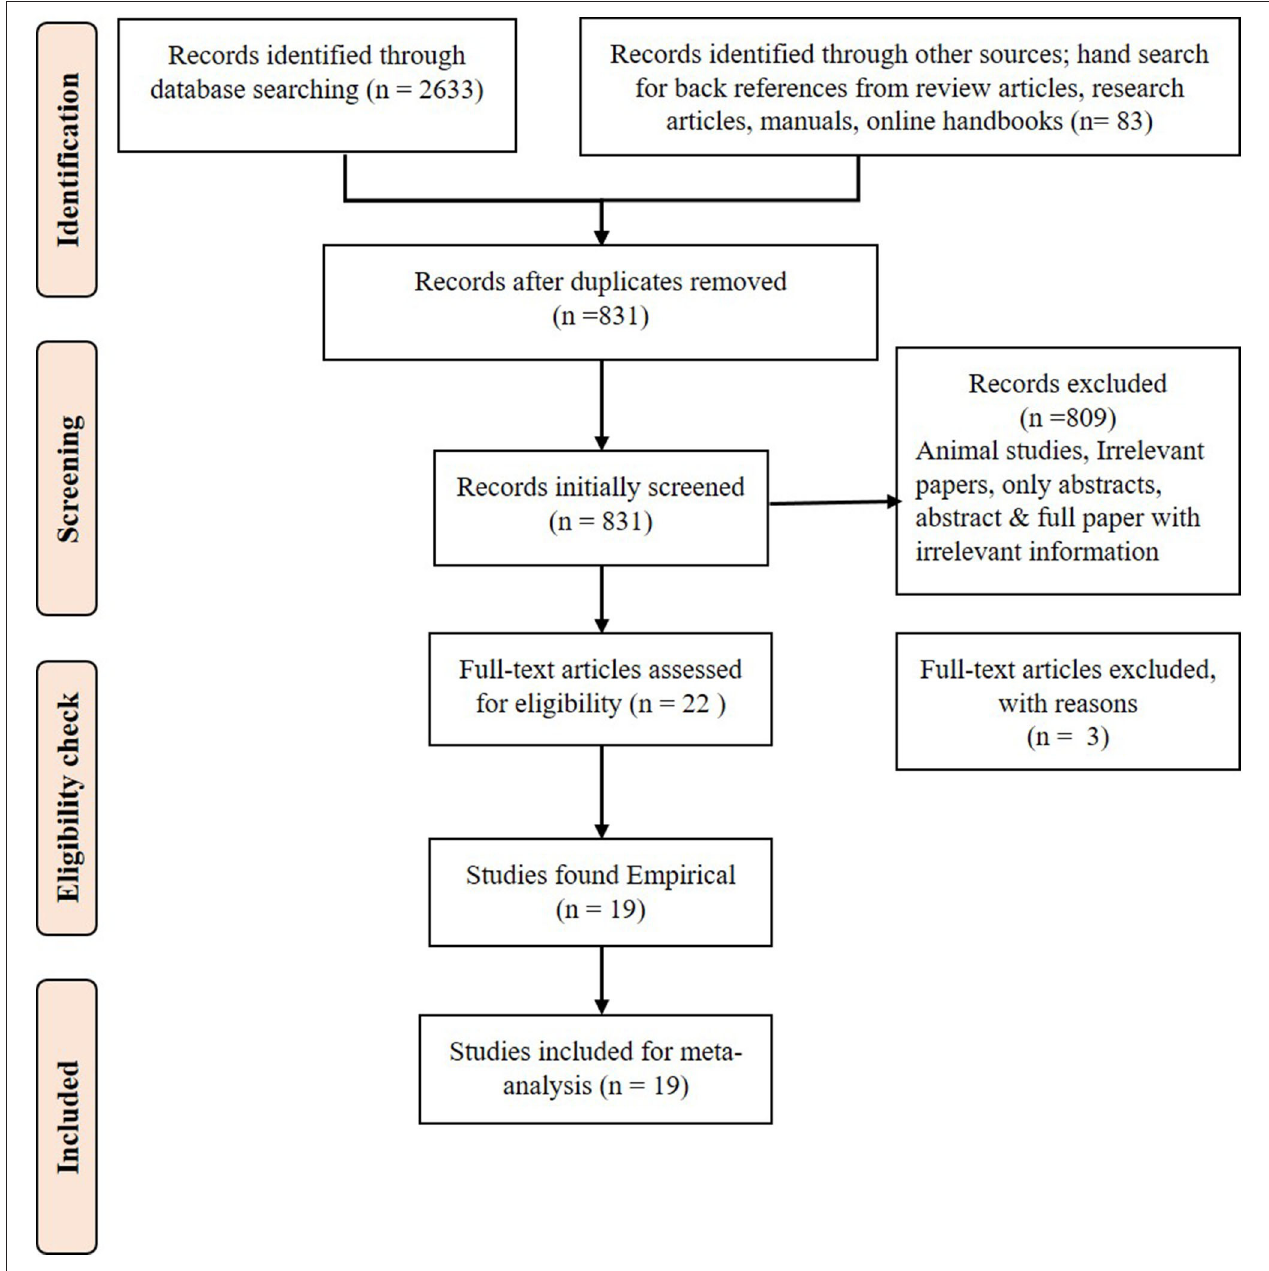
FIGURE 1 | PRISMA flow diagram for systematic